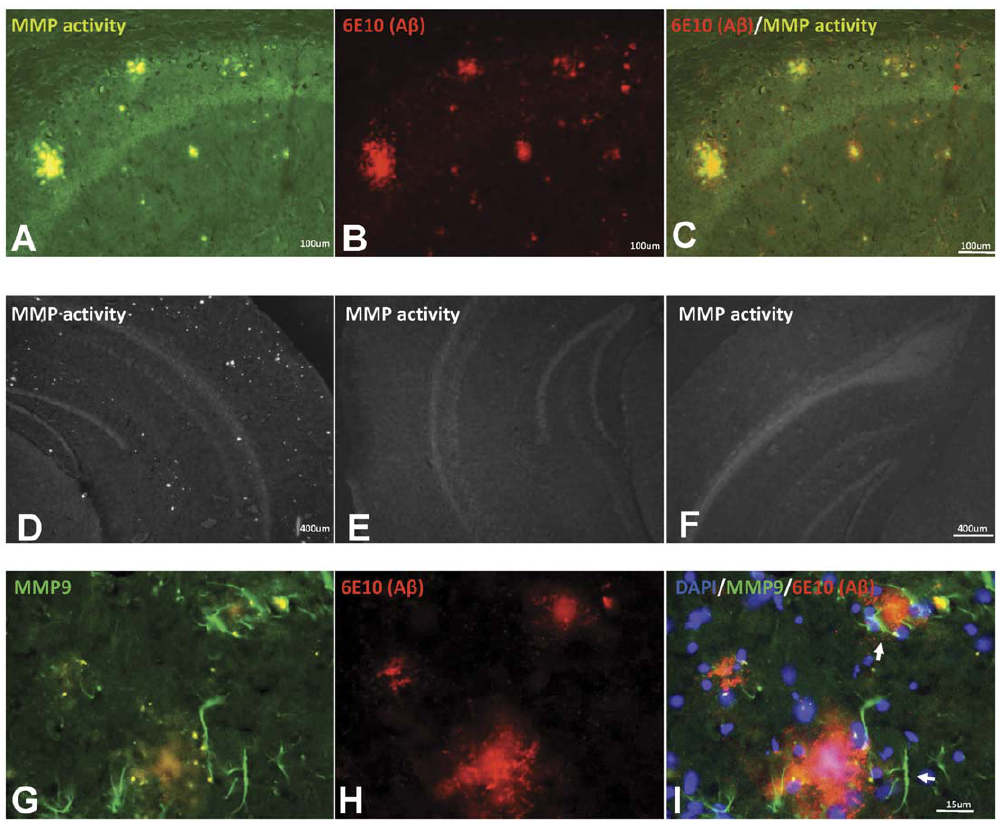
Figure 7. Localized endogenous MMP activity around A b plaques. A thin film of DQ gelatin was digested by metalloproteases, releasing fluorescence. This degradative activity occurred mainly around A b plaques (A–C). The activity of metalloproteases continued despite no new deposition of A b for one month in tetAPPsi mice (D). MMP activity was not observed in non-transgenic littermates (E) or in sections treated with the metalloprotease inhibitor, 1,10 PNTL (F). Antibody staining specific for mouse MMP9 indicated reactive endogenous cells (arrows) in close proximity to A b plaques deliver MMP9 (G–I) in APPswe/PS1dE9 mice. The images shown are representative of an analysis of at least three sections from three